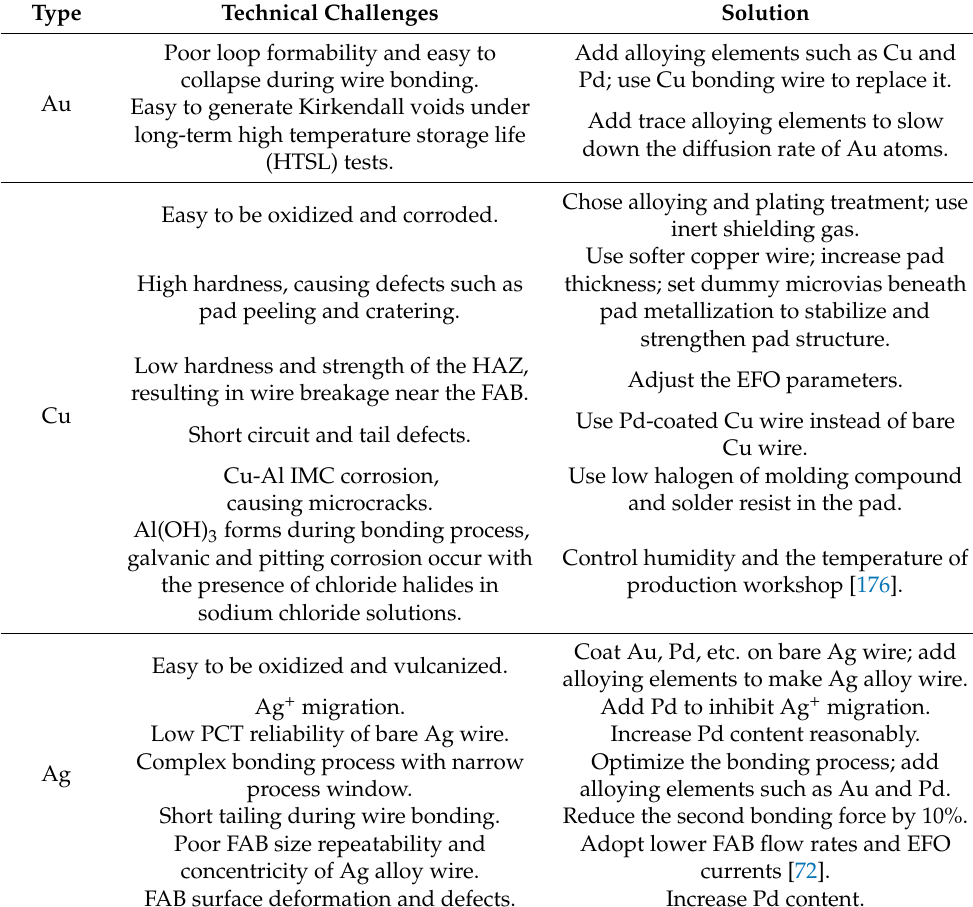
Table 4. Challenges and solutions for bonding